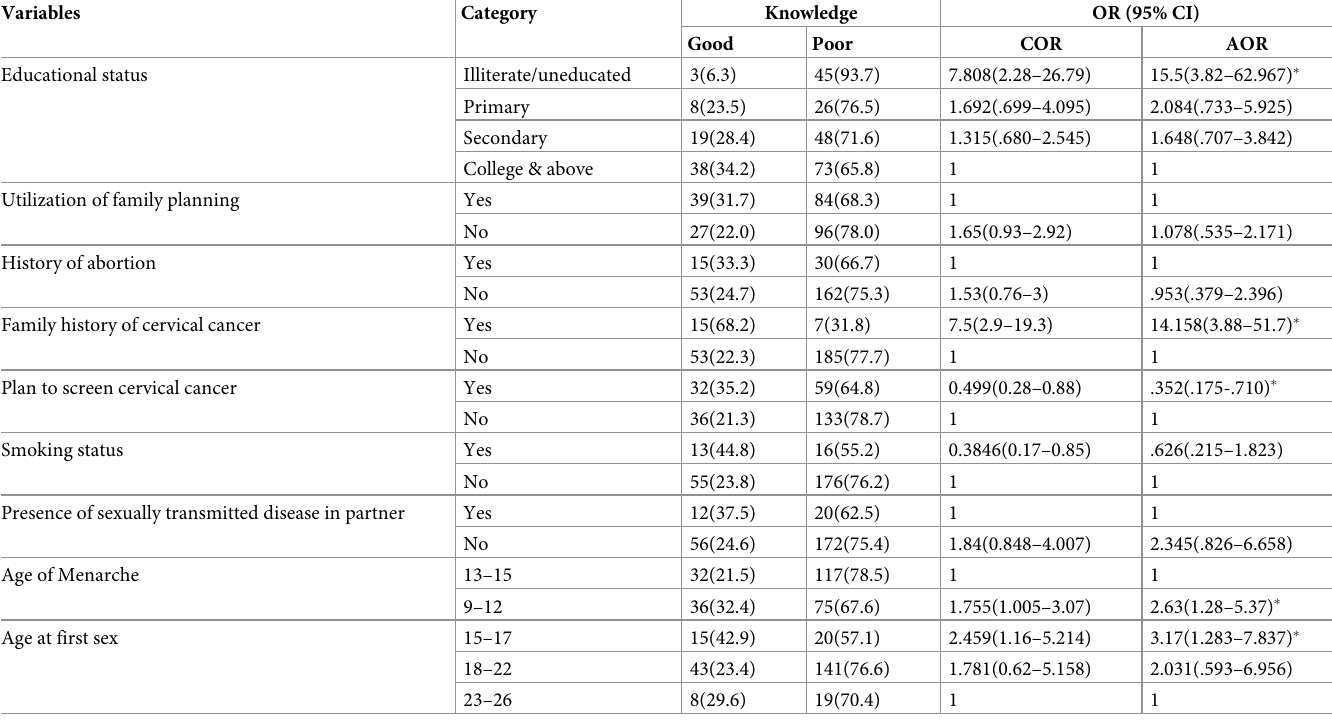
Table 6. Factors affecting knowledge of cervical cancer screening among reproductive age group women in districts of Gurage zone, Southern Ethiopia,